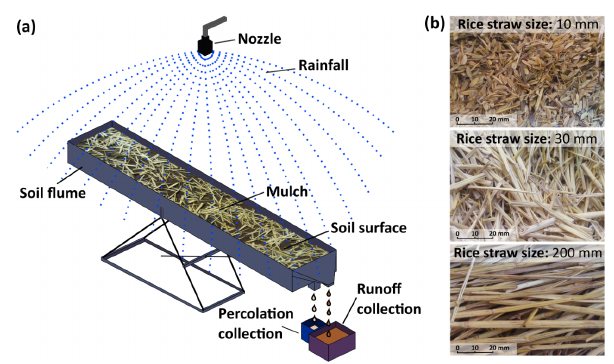
Figure 1. Laboratory setup: (a) schematic representation; and (b) rice straw mulch sizes used.